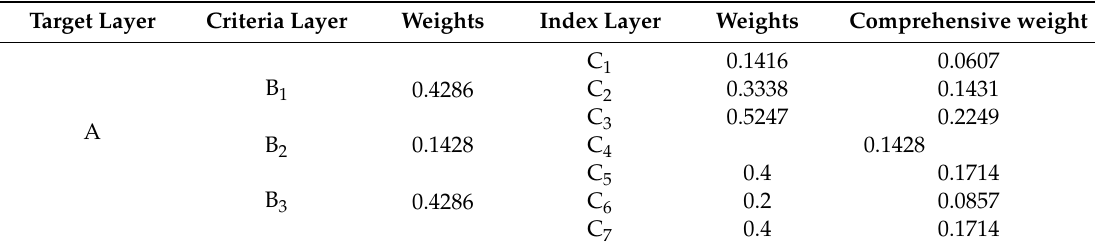
Table 9. Weight table of ecological environment bearing capacity evaluation system.